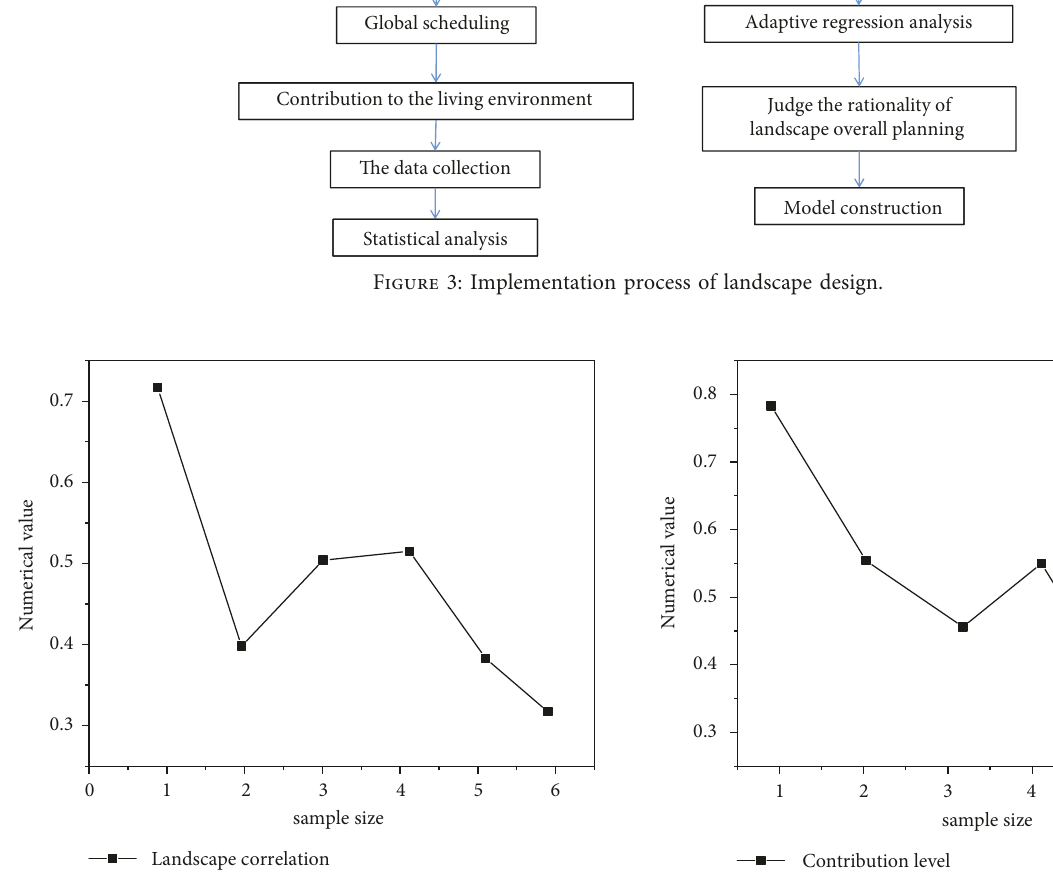
Figure 4: Landscape correlation results of sample pixels.